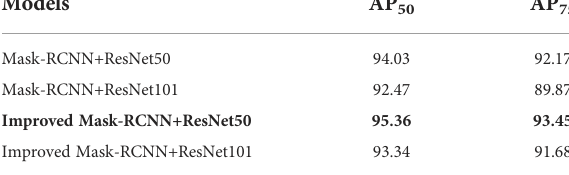
TABLE 2 Prediction results of four sets of